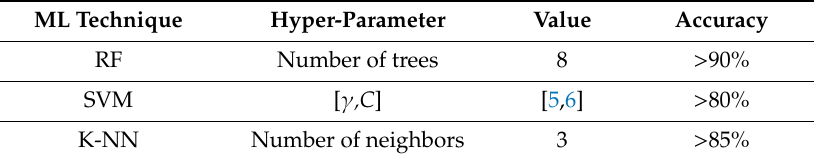
Table 7. Hyper-parameter setting and accuracy for each ML technique.